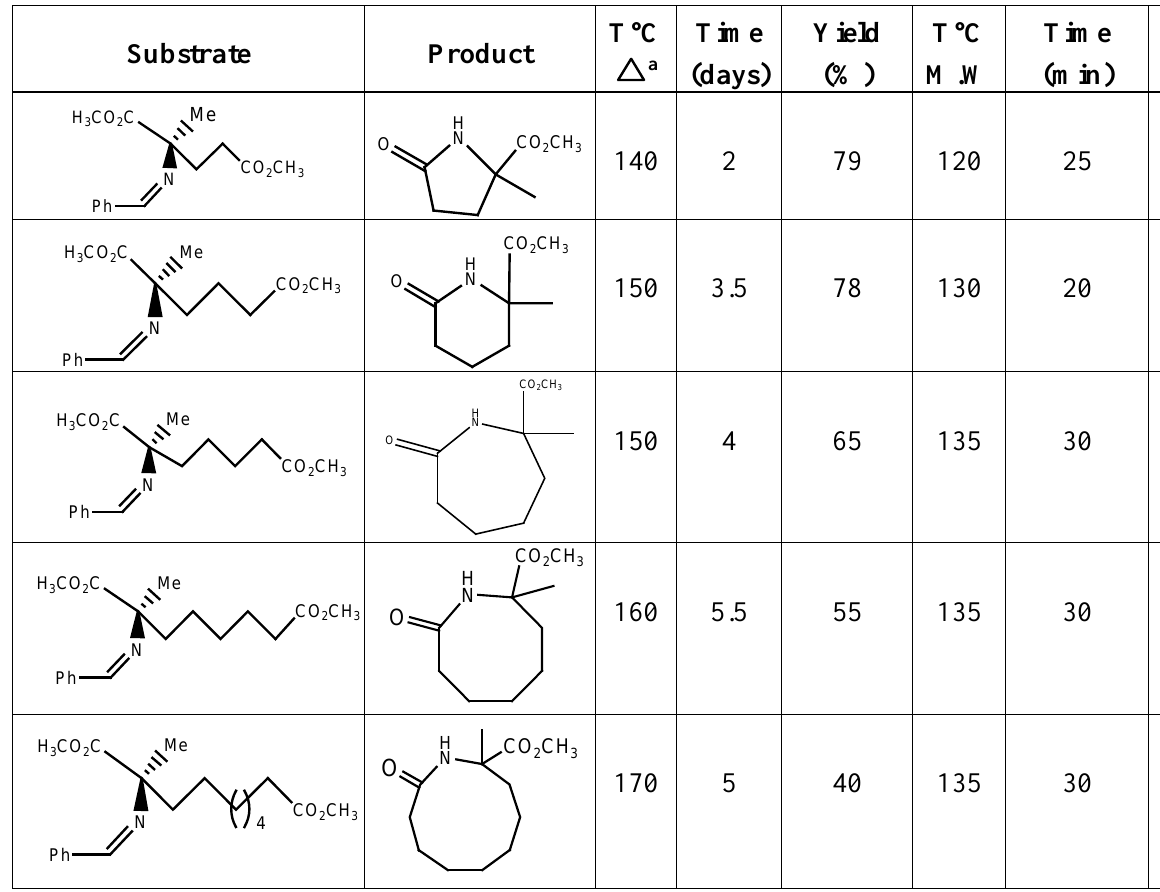
Table 3: Intramolecular cyclization of imines 1 with R =